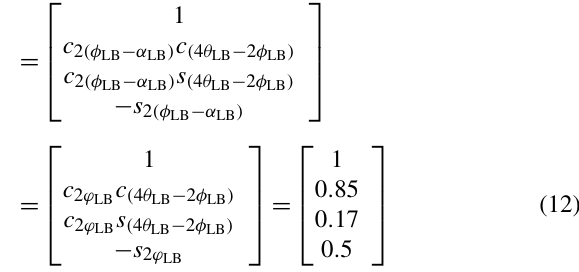
Figure 9. Linear polarizer in front of the window of laser A, placed at 45 ◦ from the x F